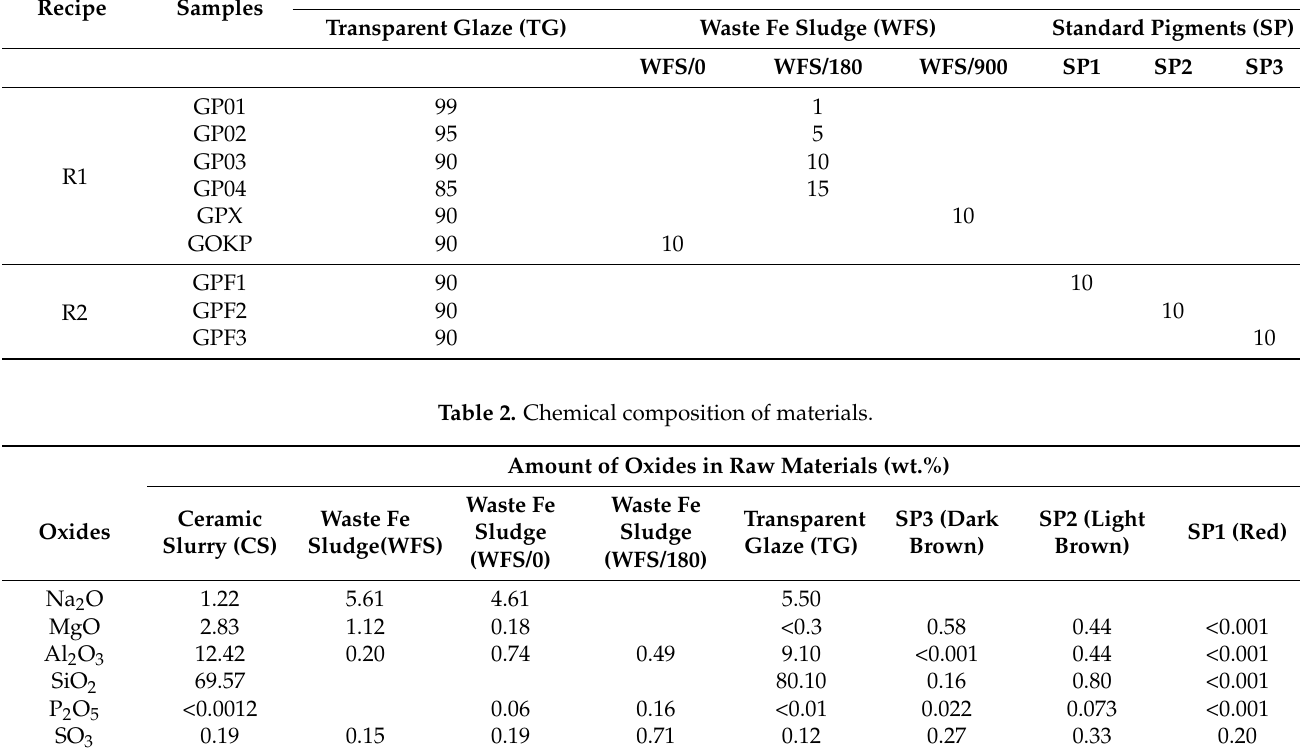
Figure 1. Commercial pigments in powder form used for preparation of glazes. Table 1. Recipe of glazes prepared from waste Fe sludge (WFS) and commercial pigment (SP, standard pigment).